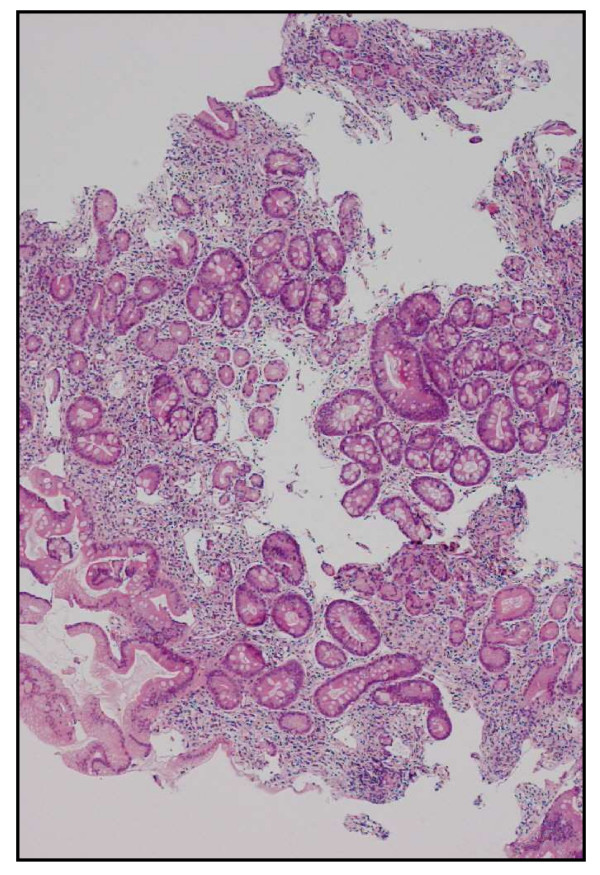
Gastric (body) biopsy (haematoxylin and eosin), 40×. Intestinal metaplasia with goblets cells. The lamina propria is filled with lymphocytes.